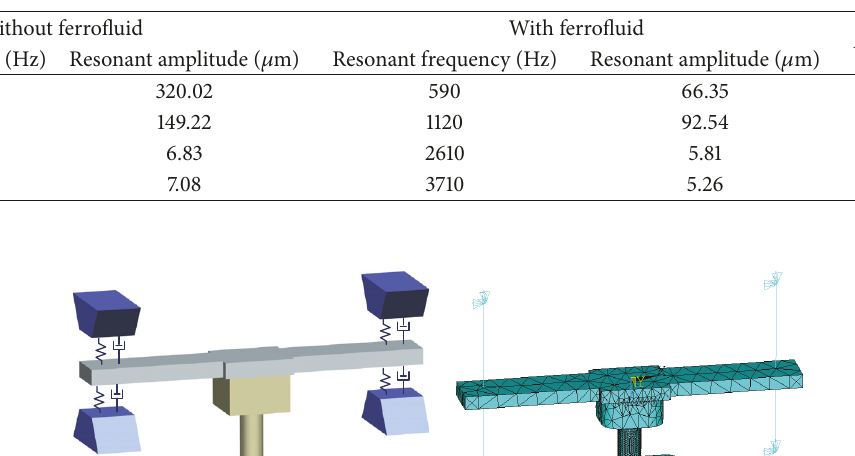
Table 3: Simulation results of dynamic characteristics of armature assembly.